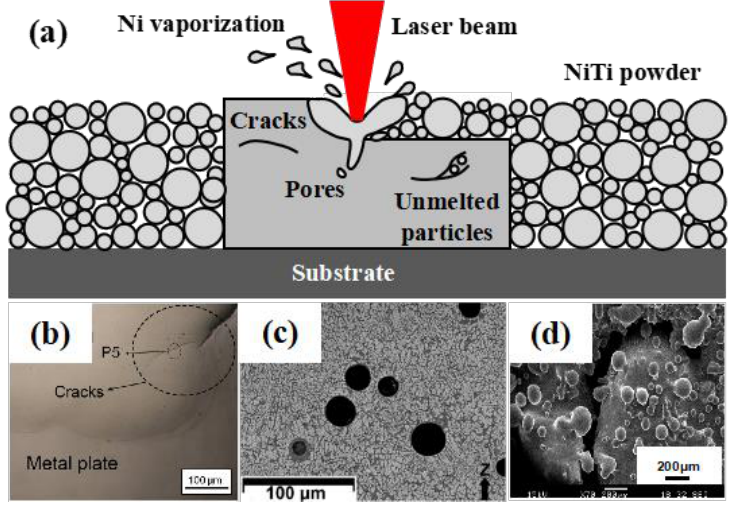
Figure 5. ( a ) Defects of Ni-Ti alloy formed by SLM; ( b ) the cracks; ( c ) the holes; ( d ) unfused particles [8].